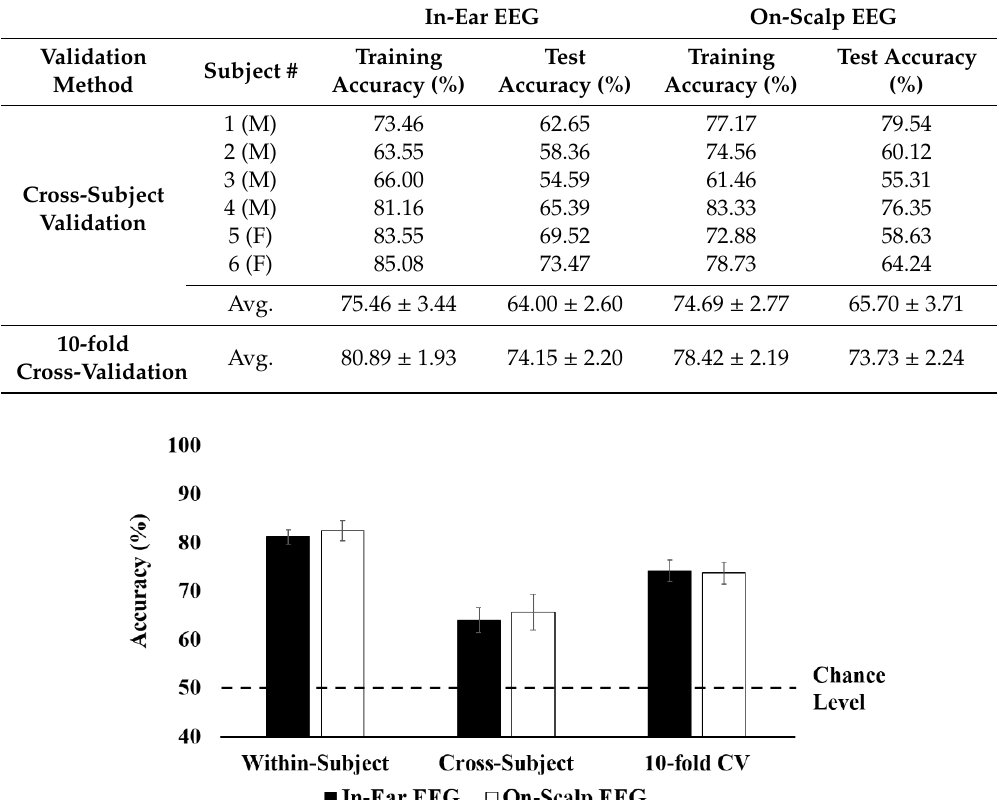
Table 3. The maximum training accuracy and test accuracy in the cross-subject validation and 10-fold cross-validation.